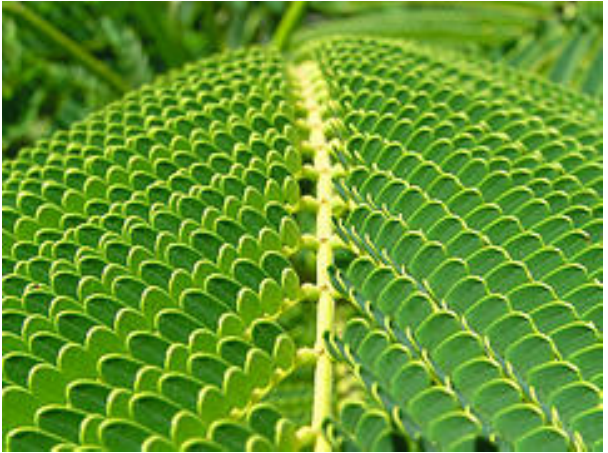
Figure 5: ‘Green is Beautiful’ by Cyron